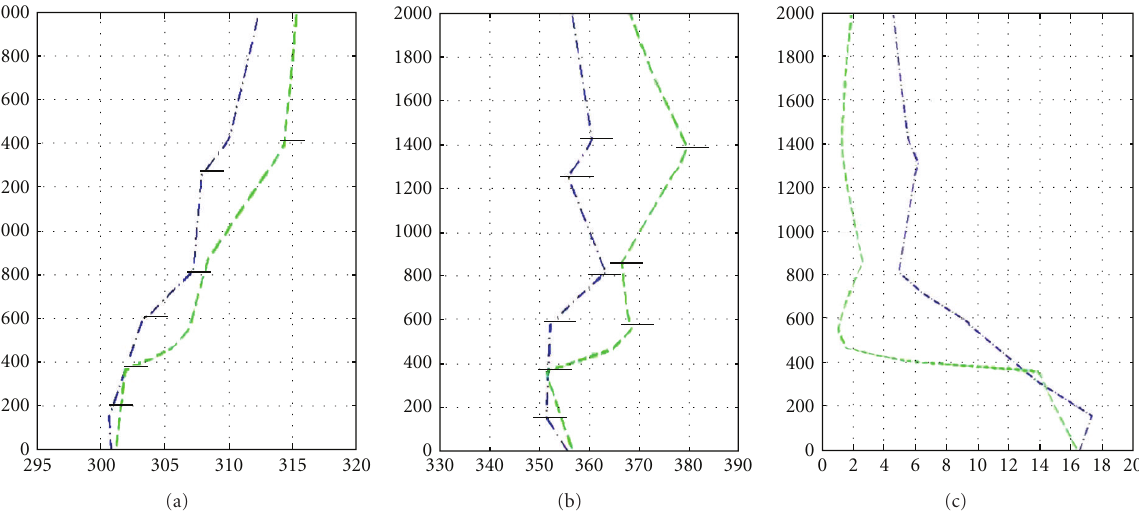
Figure 13: Potential temperature θ (a), equivalent potential temperature θ e (b), and mixing ratio r profiles (c) of 08/17/06 at 1200 UTC (blue) and 08/18/06 at 0000 UTC (green) in Dakar.